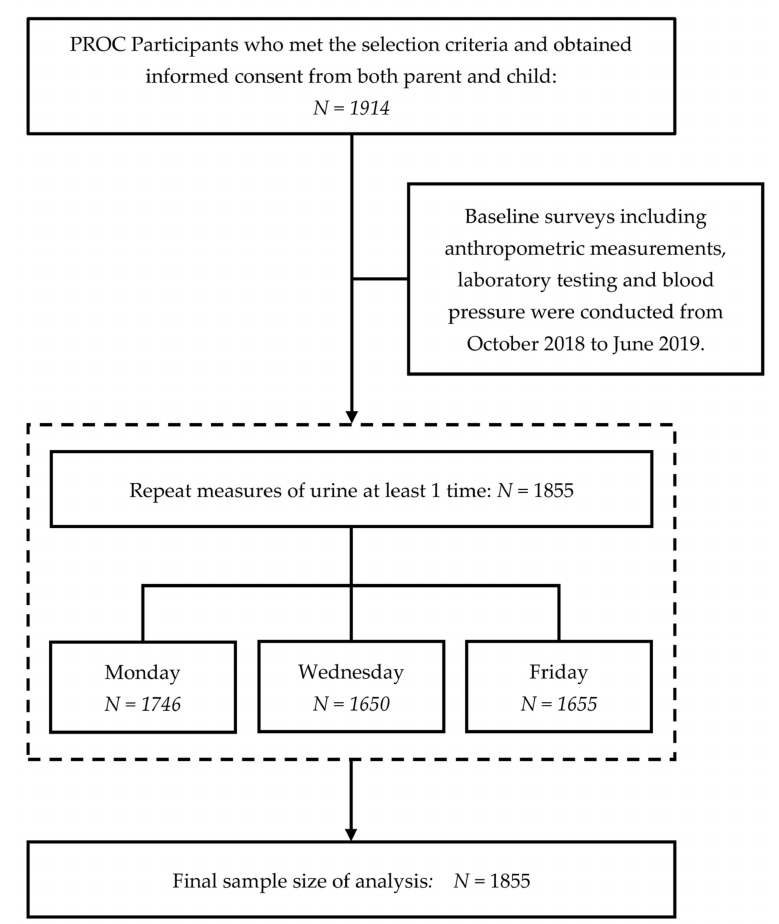
Figure 1. Flowchart of the participants’ recruitment and selection